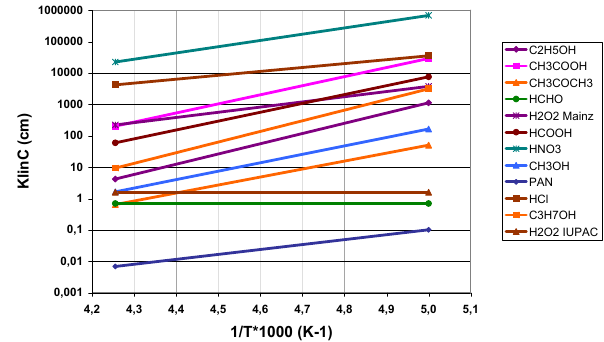
Fig. 6. Partition coefficients (cm) used in the calculations as a func- tion of the inverse of the temperature, extrapolated in the range